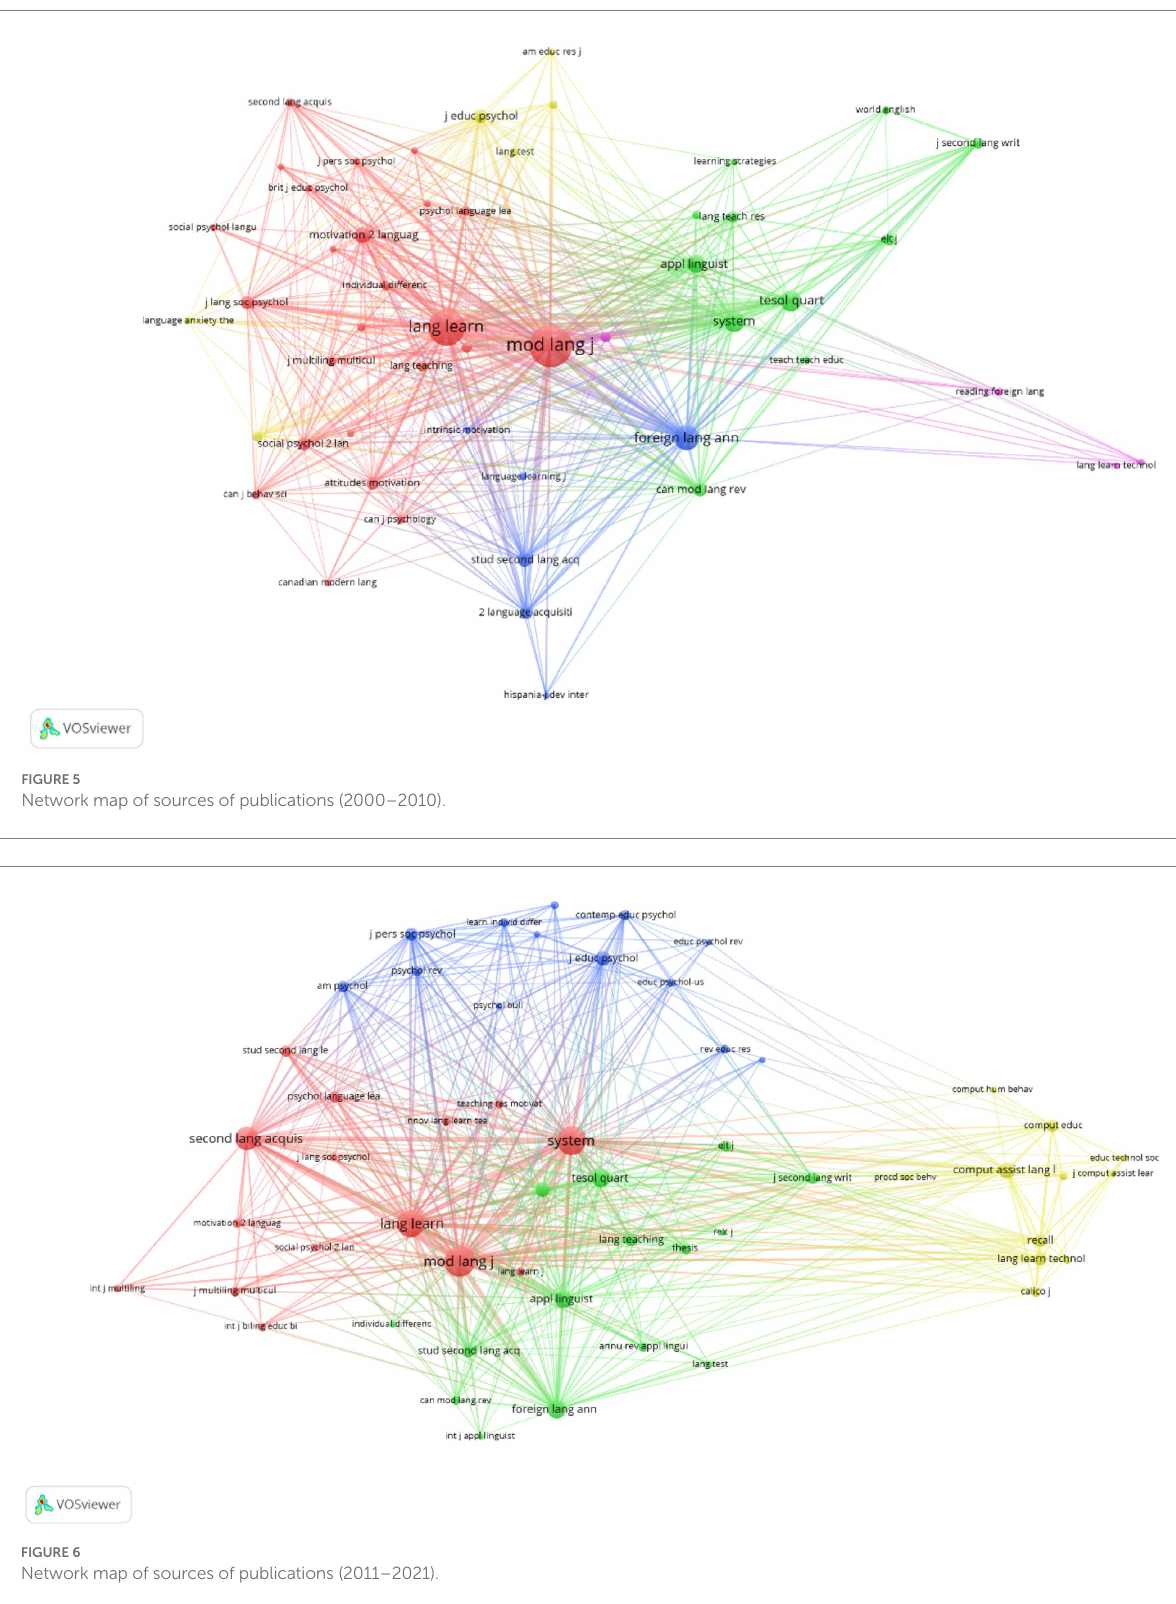
L2MSS model (Al-Hoorie, 2018), Gardner’s SE model has been overshadowed hence.